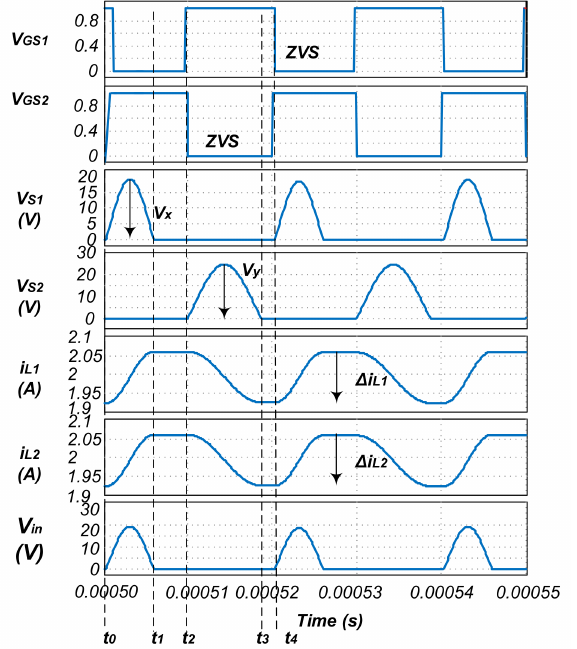
Figure 7. Simulation of 1/3-type SDRSIC to show the switching states. Stage 1 [ t 0 − t 1 ]: Figure 6a shows the switching states, S 1 is switched off and S 2 is switched on to start the resonance process at t 0 . Figure 6a shows the operation. L 1 and L 2 are in parallel through S 2 , D 1 c , and D 2 a in forward conduction, and L L through D L , to carry the input current I in . The output is represented by L L and R L . The resonant tank is formed by L 1 , L 2 , and C 1 . Voltage on C 1 performs a half-cycle sinusoidal voltage under zero voltage off and on at t 0 and t 1 , respectively. Because the switch S 1 is in parallel with C 1 , it is under zero voltage switching. It can also be seen that the inductor currents i L 1